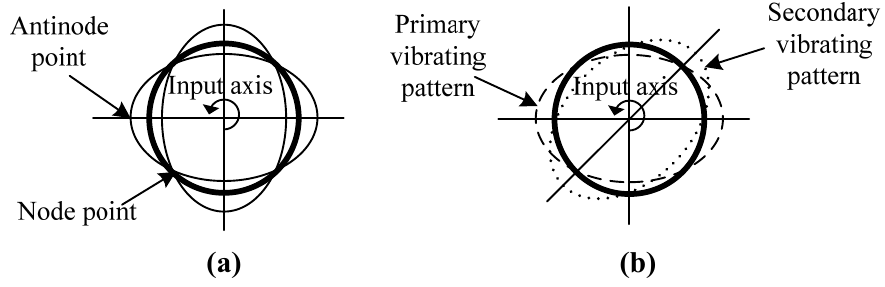
Figure 1. (a) Standing wave on the resonator with four nodes and antinodes. (b) Primary vibrating pattern and secondary vibrating